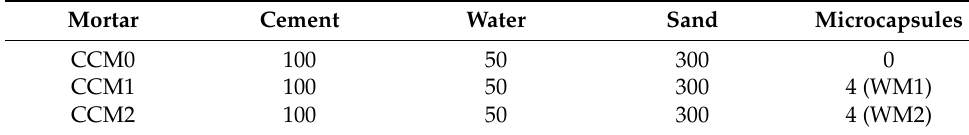
Table 4. Formulations of mortars according to the weight